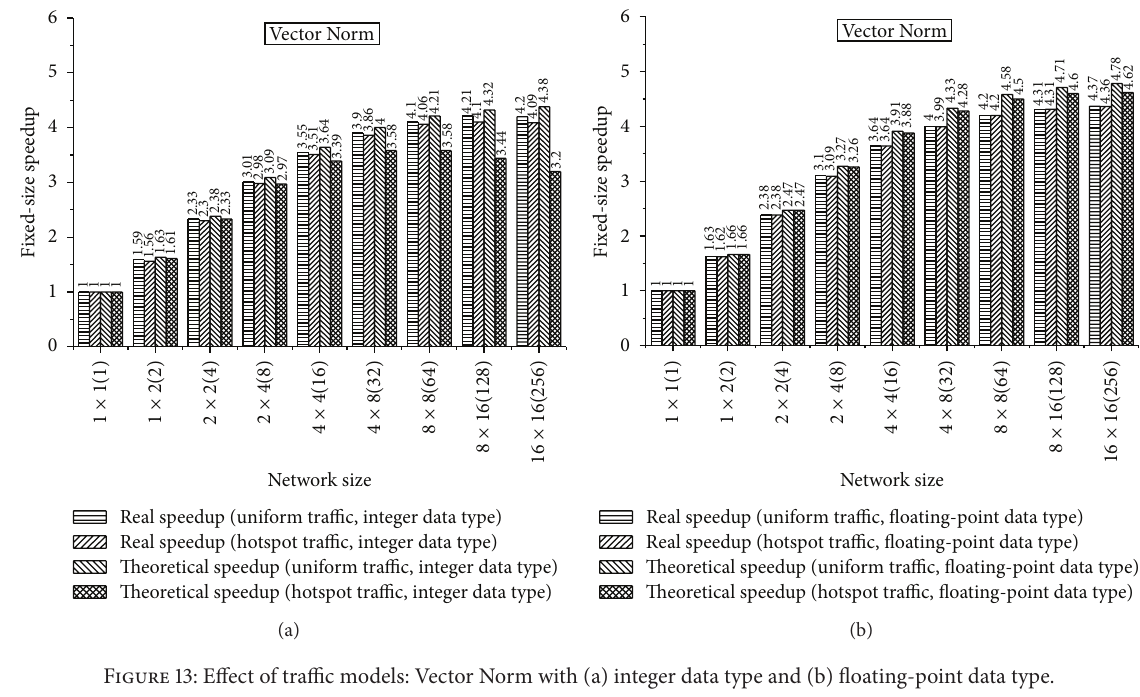
Figure 13: Effect of traffic models: Vector Norm with (a) integer data type and (b) floating-point data type.